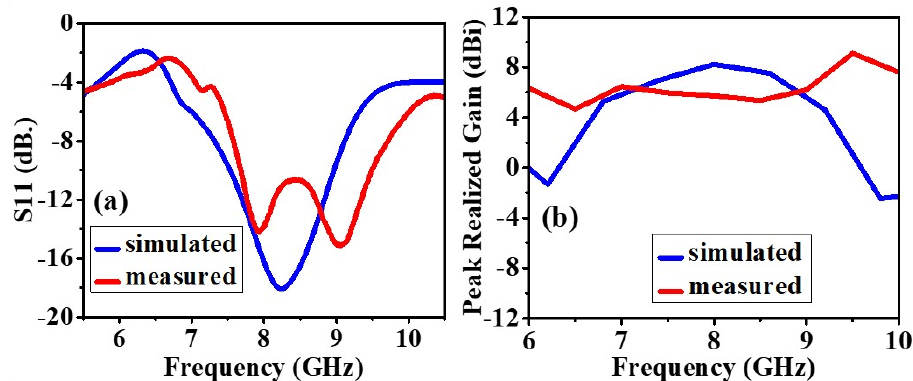
Figure 6. Without AMC: ( a ) The measured and simulated reflection coefficient (S11), ( b ) The measured and simulated maximum gain of the prototype.